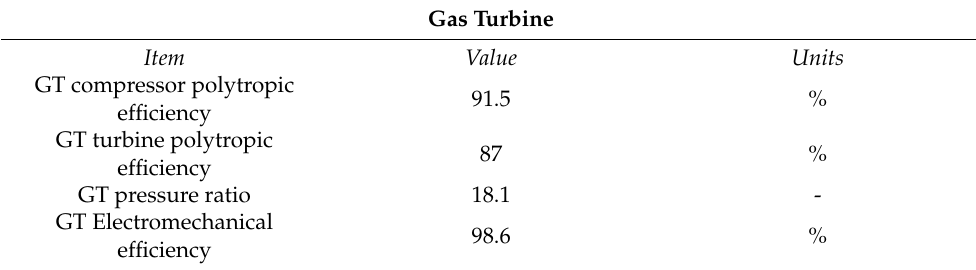
Table A3. Power cycle